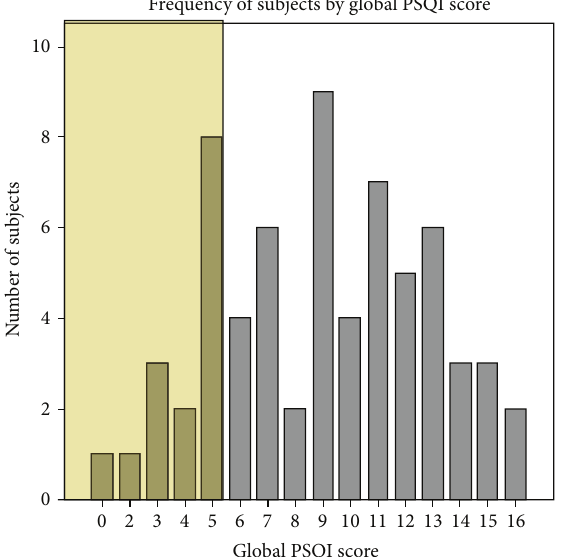
Figure 2: Global PSQI score over the entire study group. The shaded area is considered normal sleep.